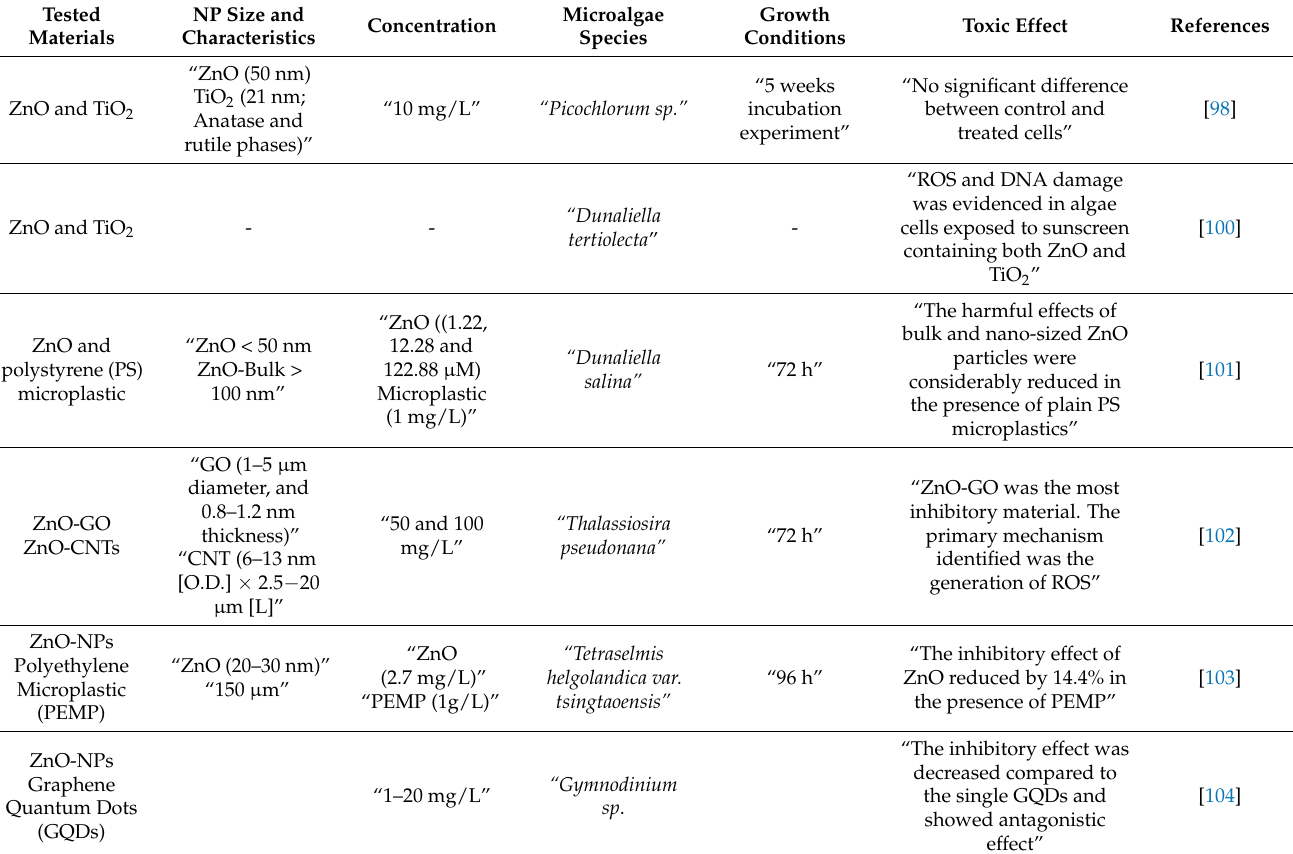
Table 3. Combined toxicity effects of ZnO-NPs with different materials of marine